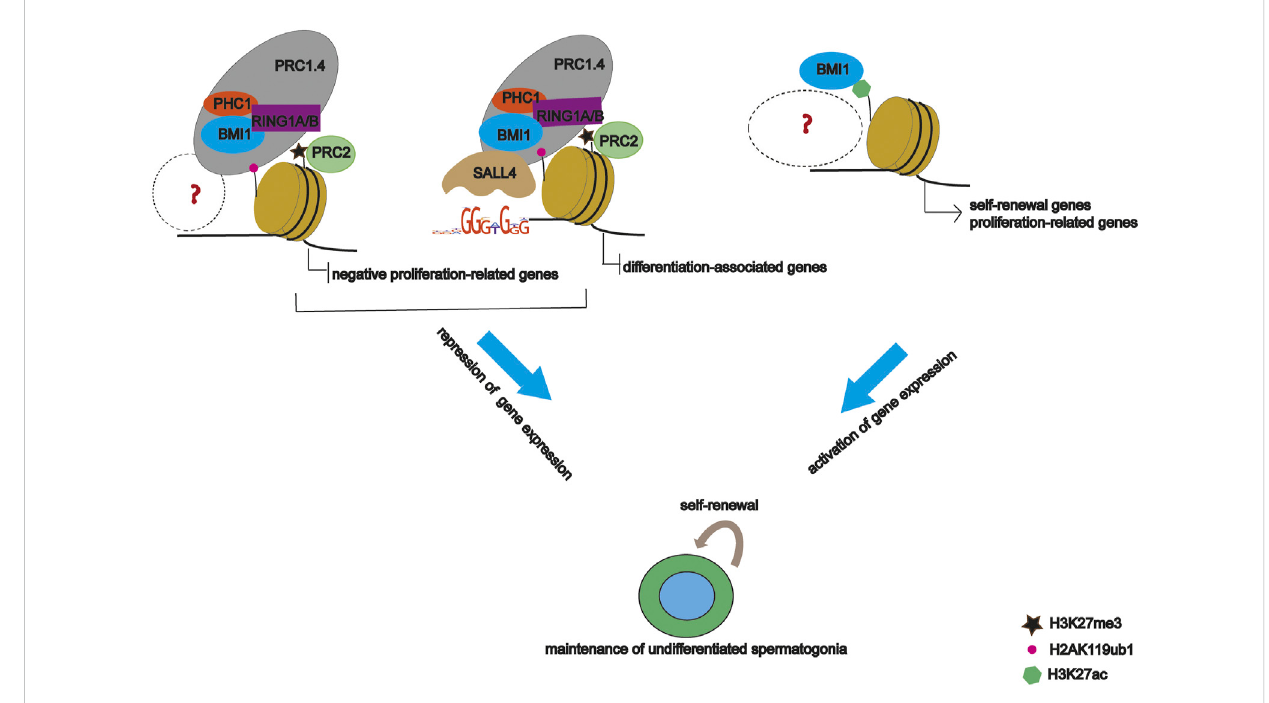
FIGURE 7 Proposed model of BMI1 regulation in undifferentiated